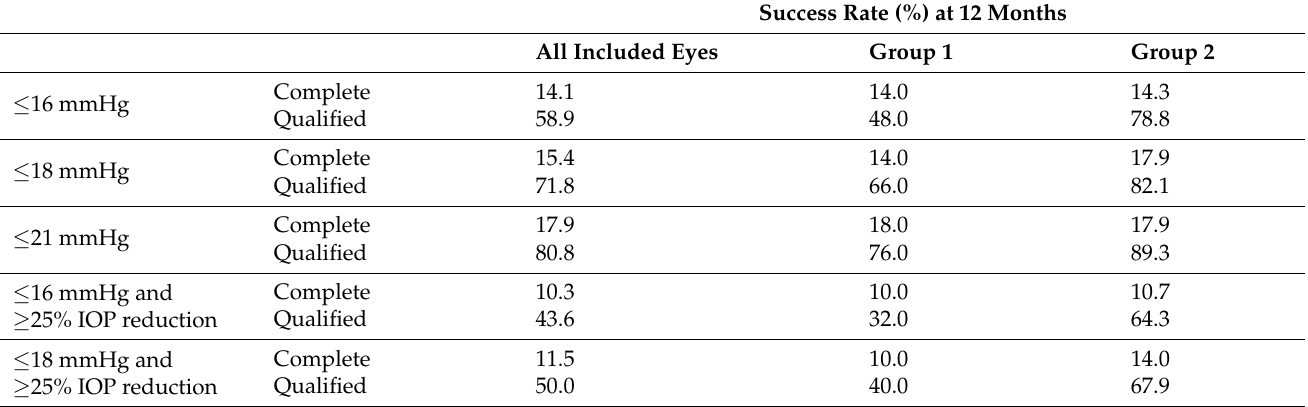
Table 3. Success rates overall and in the groups at 12